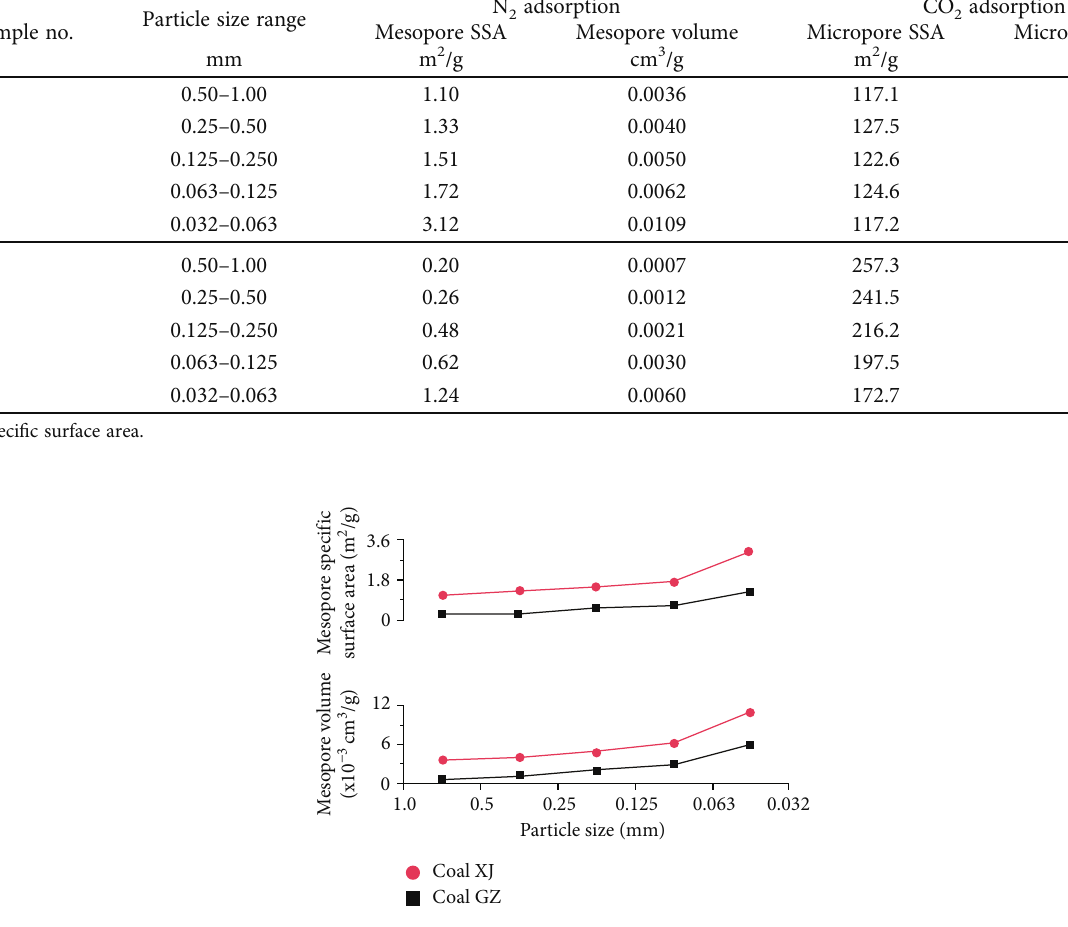
Figure 4: Variations in mesopore structure parameters of the coal samples with di ff erent particle